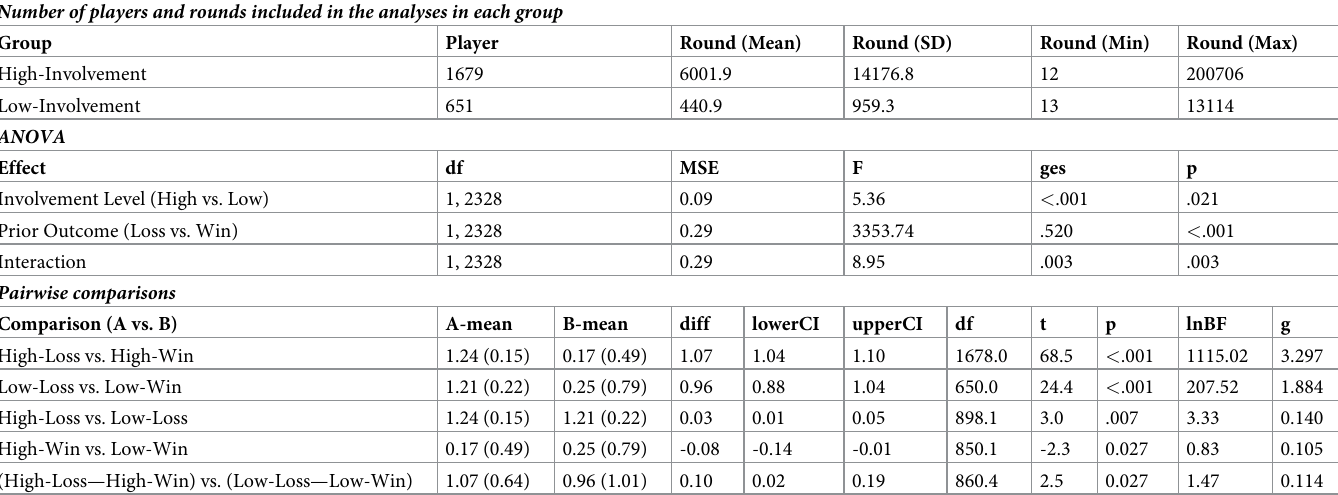
Table 4. Statistical analyses on when to